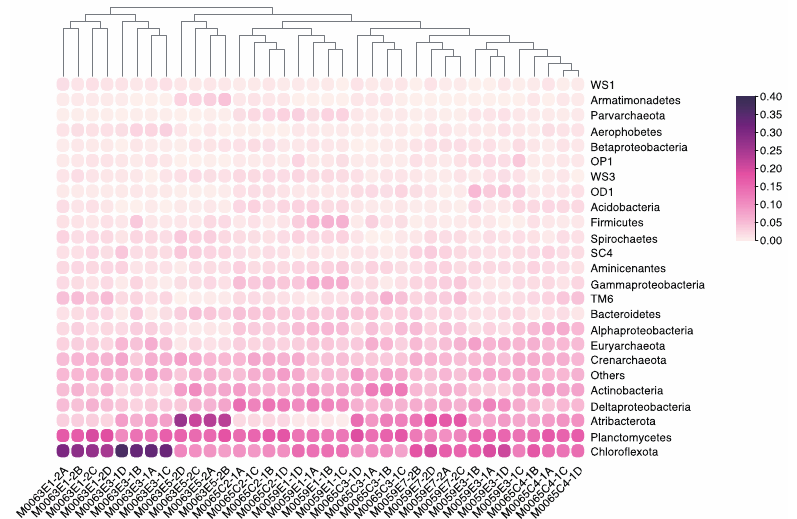
Figure 5. Comparison of the phylogenetic composition at phylum level. The relative abundance is visualized as the changes of colors.